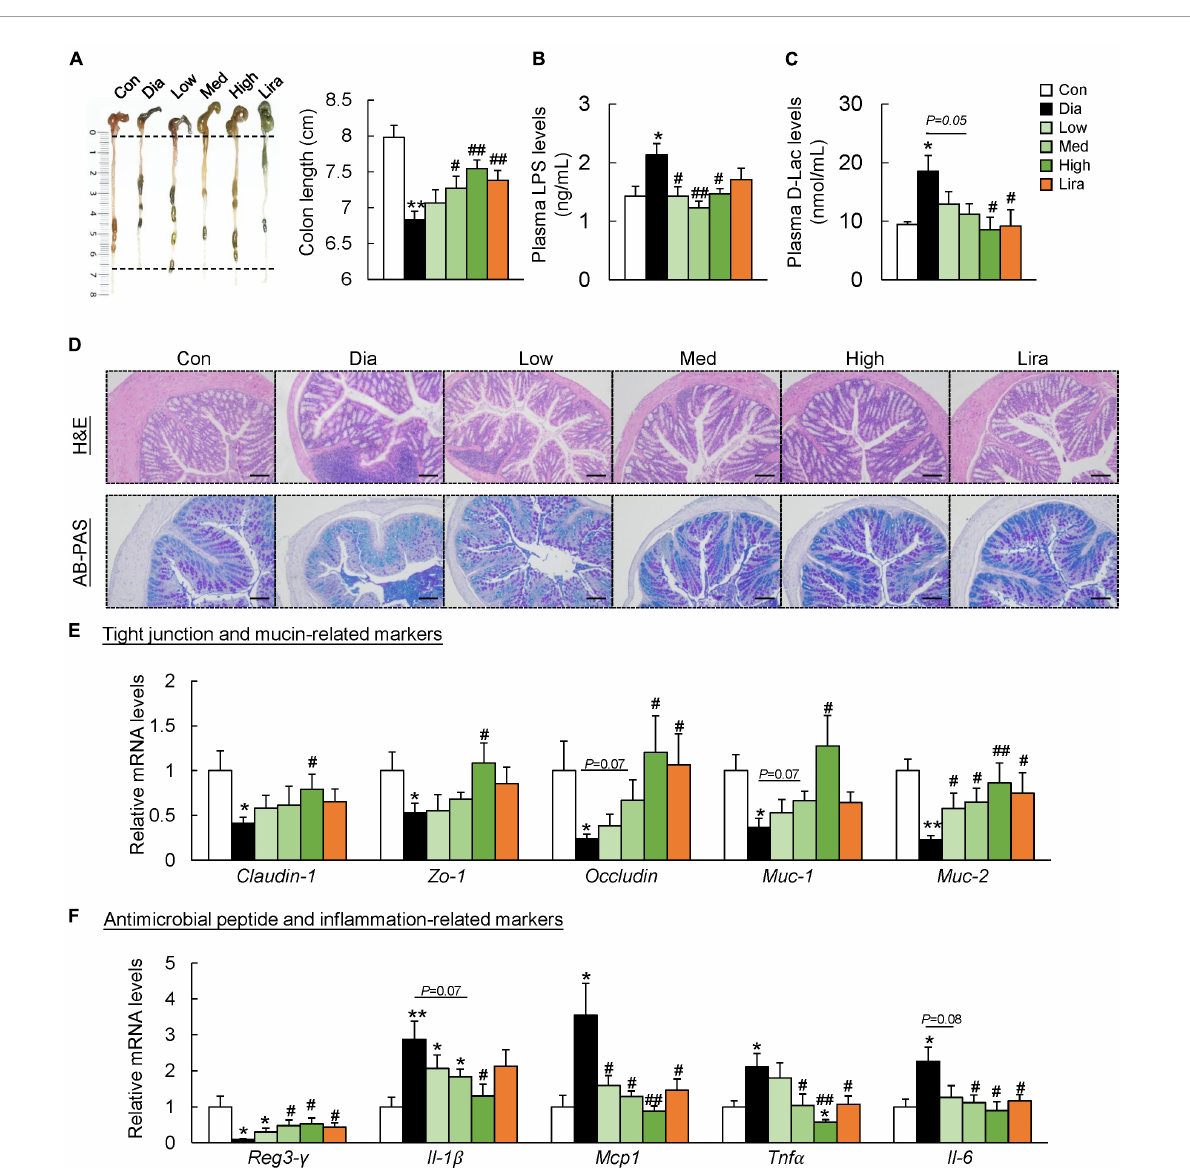
FIGURE4 CFP administration improves the gut barrier function. (A) Representative pictures of the colons and colon length. (B) Plasma LPS levels. (C) Plasma D-Lac levels. (D) H&E and AB-PAS staining of the colon, Scale bar: 100 µ m. (E) mRNA expression of the tight junction- and mucin-related markers in the colon. (F) mRNA expression of the antimicrobial peptide- and inflammation-related markers in the colon. Data are presented as the means ± SEM, * P < 0.05, ** P < 0.01 vs. control; # P < 0.05, ## P < 0.01 vs. Dia.